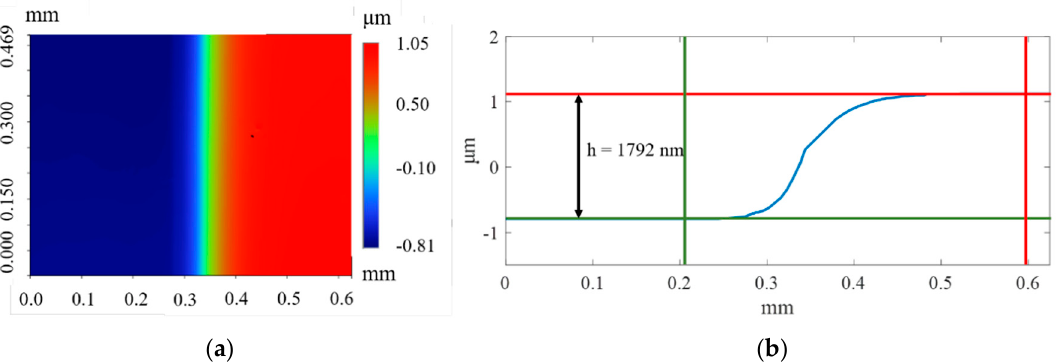
Figure 11. Single − point test result: ( a ) step topography, ( b ) step height profile (red horizontal line: the coated area, green horizontal line: the uncoated area, blue line: step height profile).